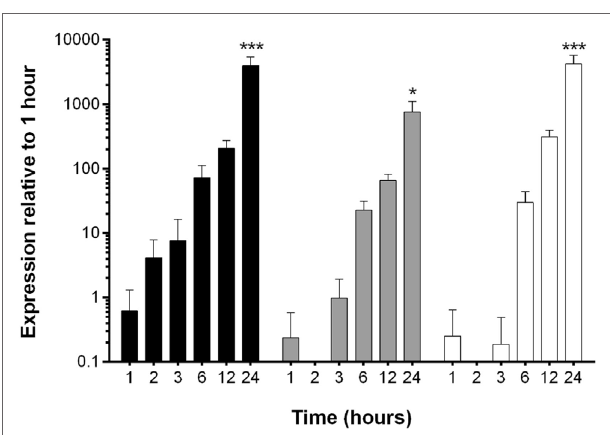
FigUre 3 | Kinetic analysis of equine herpesvirus type 1 gene expression during lytic infection of primary equine fetal kidney cells (EFKCs). Expression of the IE gene was detected in EFKCs starting at 1 hpi (black bars), whereas expression of UL5 (gray bars) and gB (white bars) genes was not consistently detected until 3 and 6 hpi, respectively. Data are shown as mean plus SD. Statistical significance is indicated by asterisks and denotes an increase at 24 hpi compared to all earlier time points (* p < 0.05, *** p < 0.0001).